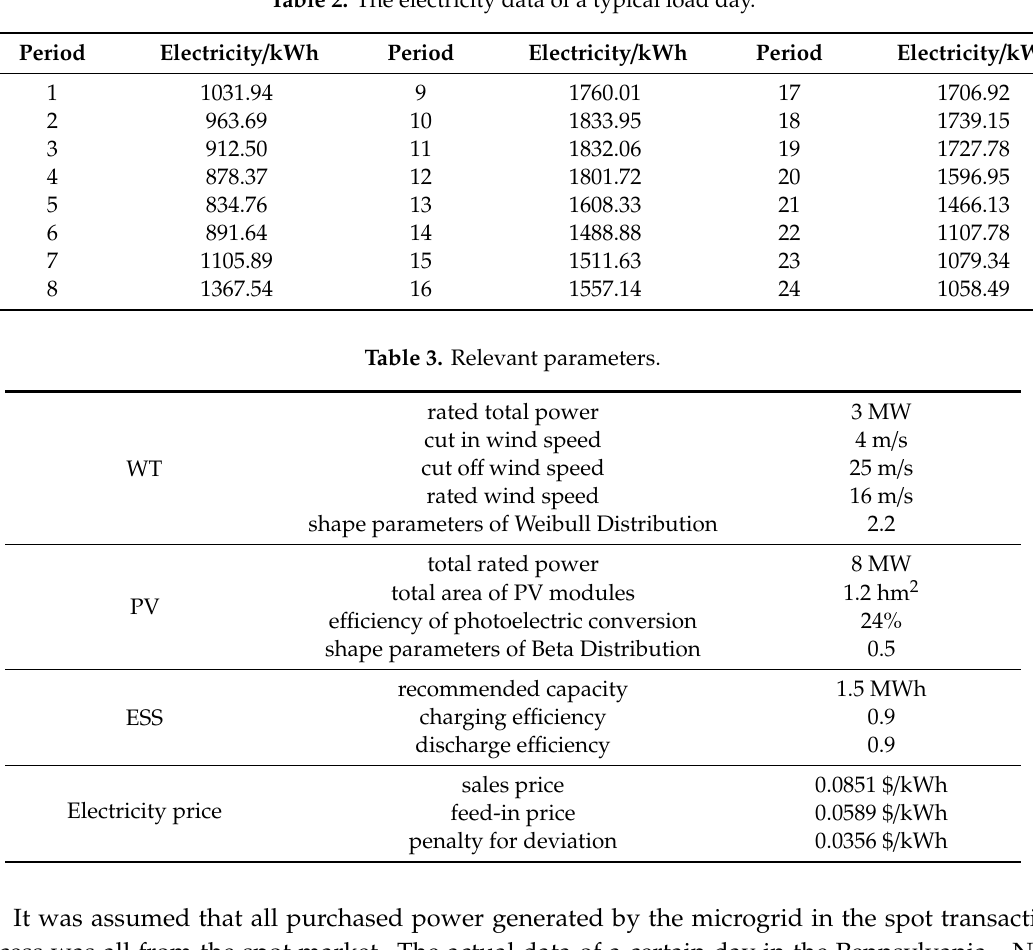
Table 2. The electricity data of a typical load day.